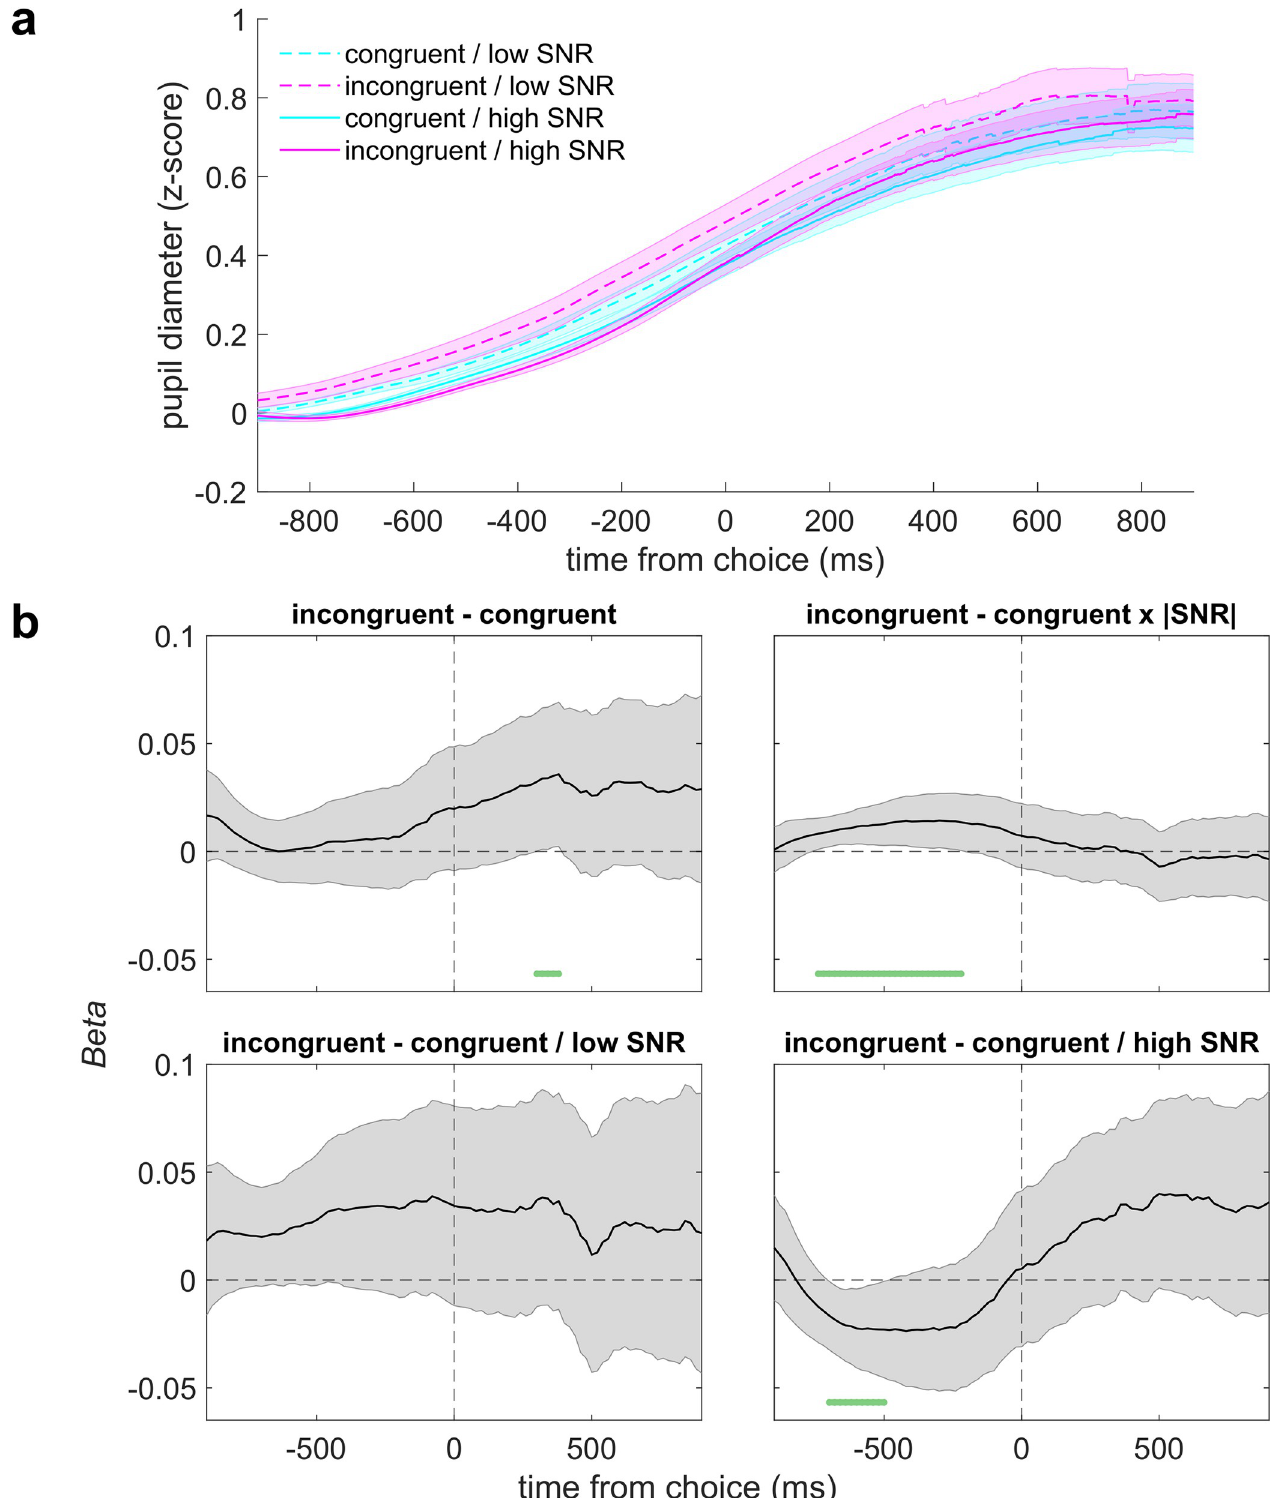
Fig 8. Stimulus-based cues weakly modulated pupil-linked arousal. A Pupil diameter on correct trials, aligned to choice and plotted as a function of the congruence of the choice and the most-recently heard pre-test tones, separated by SNR. We only used pre-test sequences ending in two of the same tone (i.e., LL, HH) and at the lowest or highest unsigned test-tone SNR for this analysis. Lines and error bars are means and SEM across all trials and subjects. B